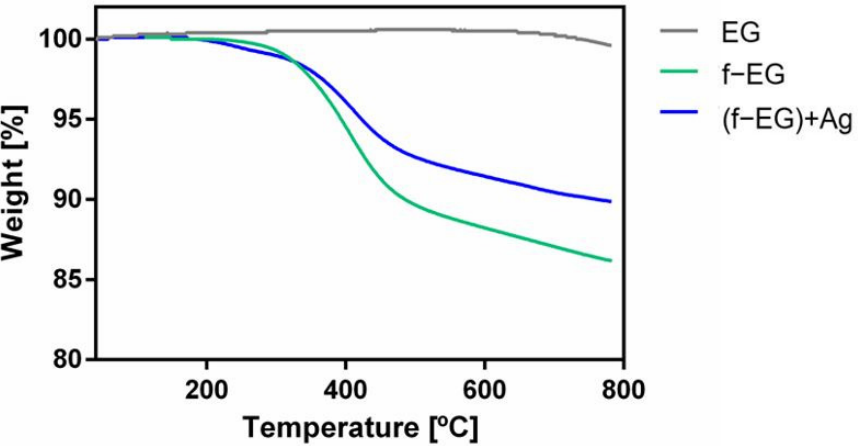
Figure 5. TGA curves for pristine EG, f-EG, and [(f-EG)+Ag].